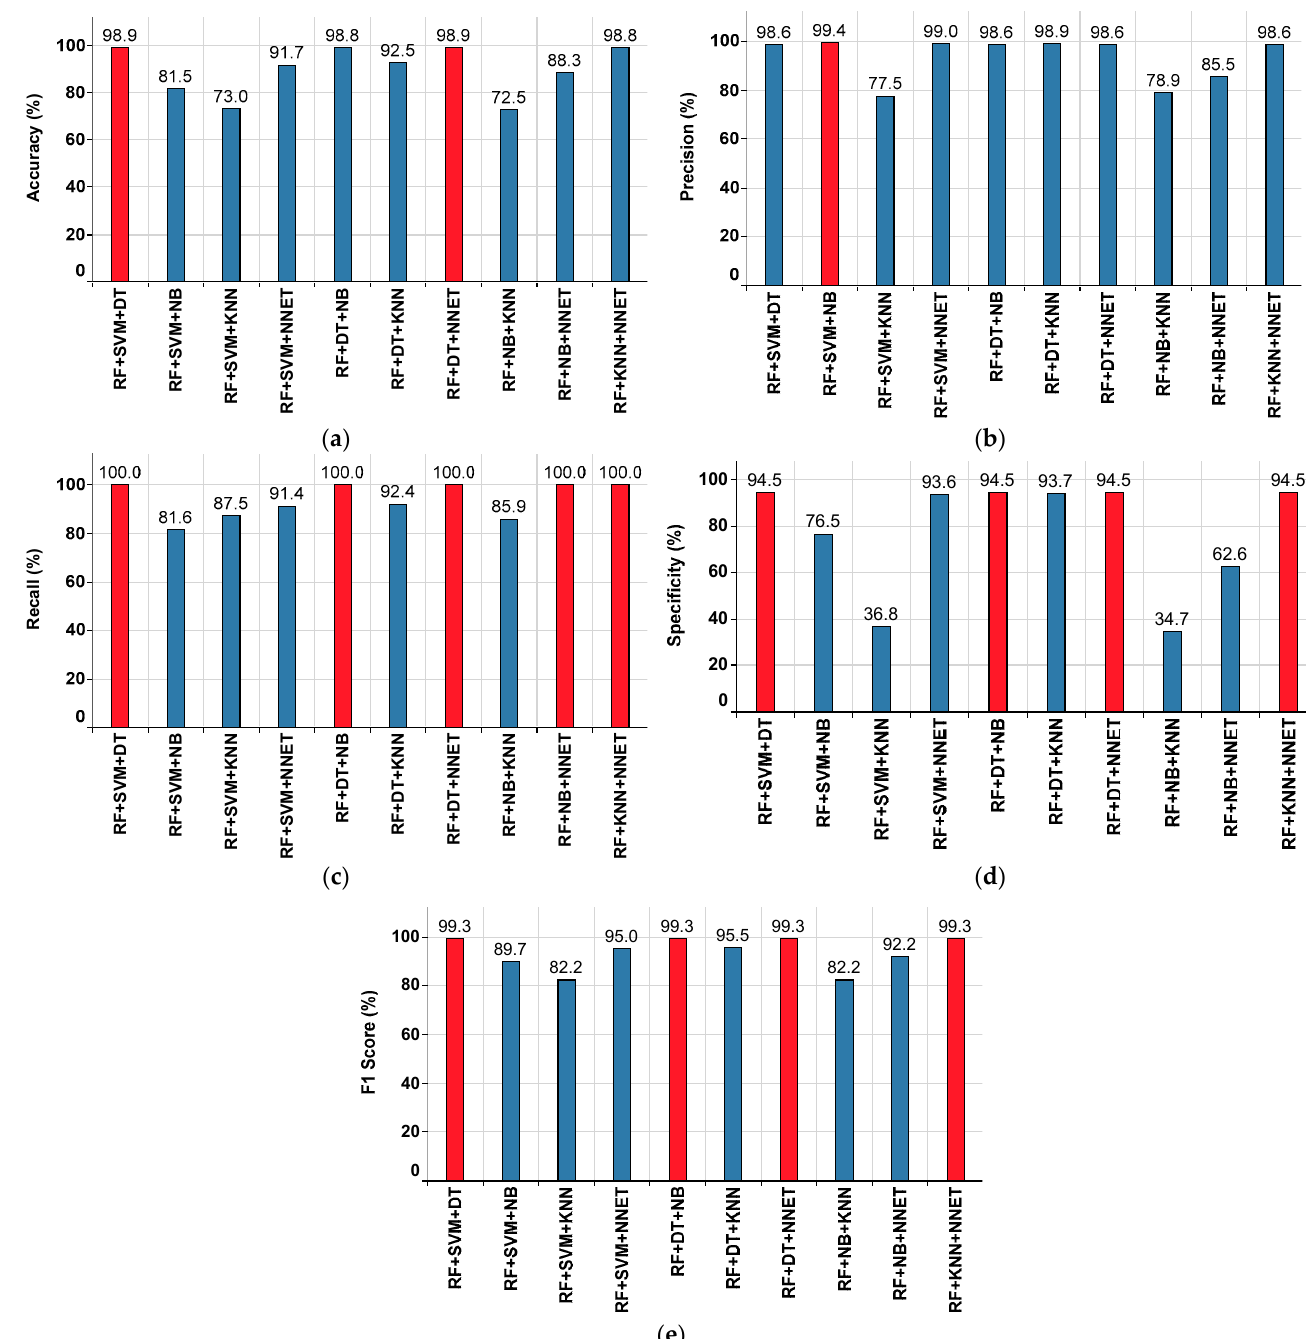
Figure 10. Performance metrics for the ensemble classifiers approach on the median imputed dataset. ( a ) Accuracy. ( b ) Precision. ( c ) Recall. ( d ) Specificity. ( e ) F1 Score.